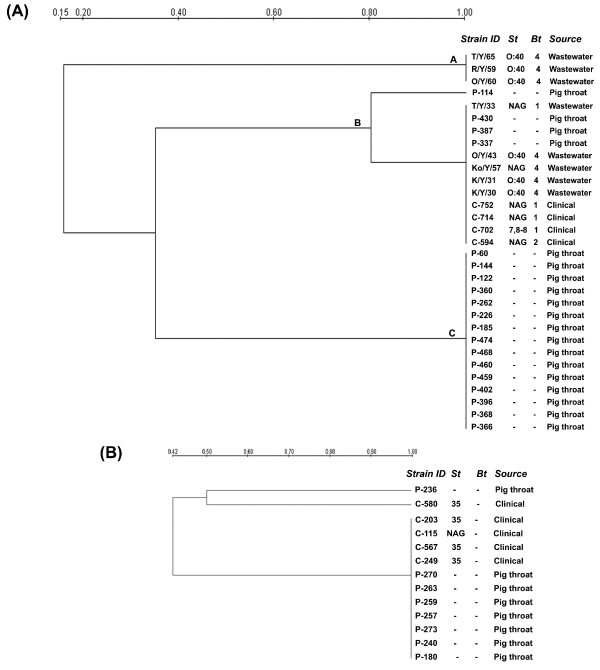
Phylogenetic analysis of blaB gene of (A)Y. intermedia and (B) Y. frederiksenii. NAG, non-agglutinable; -, Not determined; St, Serotype; Bt, Biotype